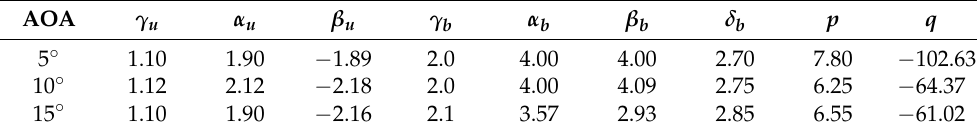
Figure 7. ( a ) External Pressure Coefficients for V = 10 m/s and 5 ◦ ≤ AOA ≤ 15 ◦ ; ( b ) Internal Flow Factor for V = 10 m/s and 5 ◦ ≤ AOA ≤ 15 ◦ . Table 6. Pressure coefficients’ model parameters for the ASCENDER airfoil at 10 m/s and an angle of attack between 5 ◦ and 15 ◦